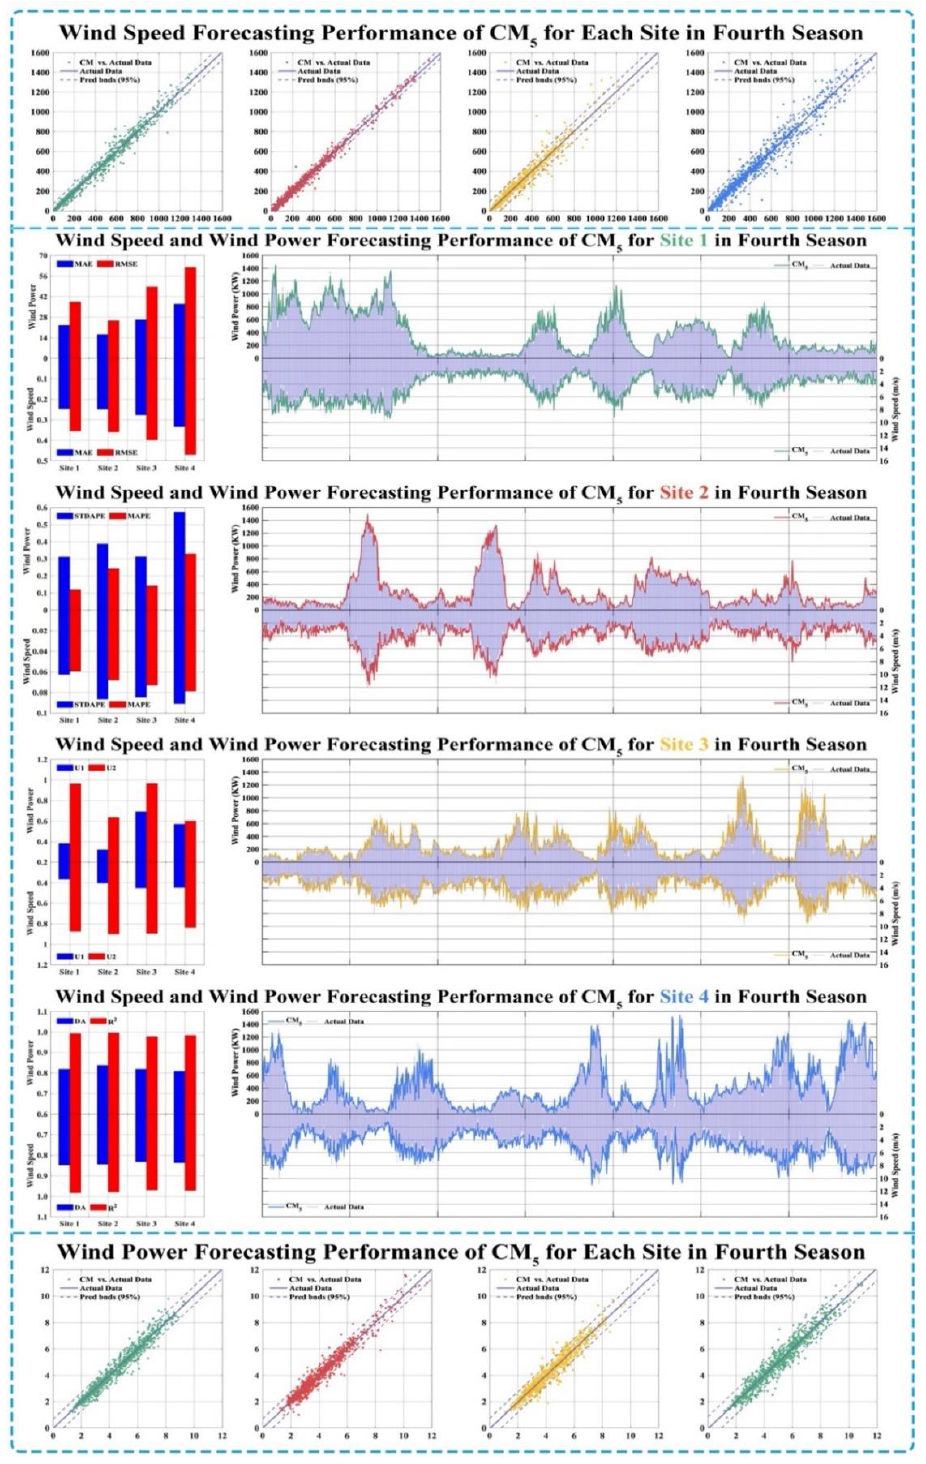
Figure 5. Wind speed and wind power forecasting result for each site by the CM5 model.